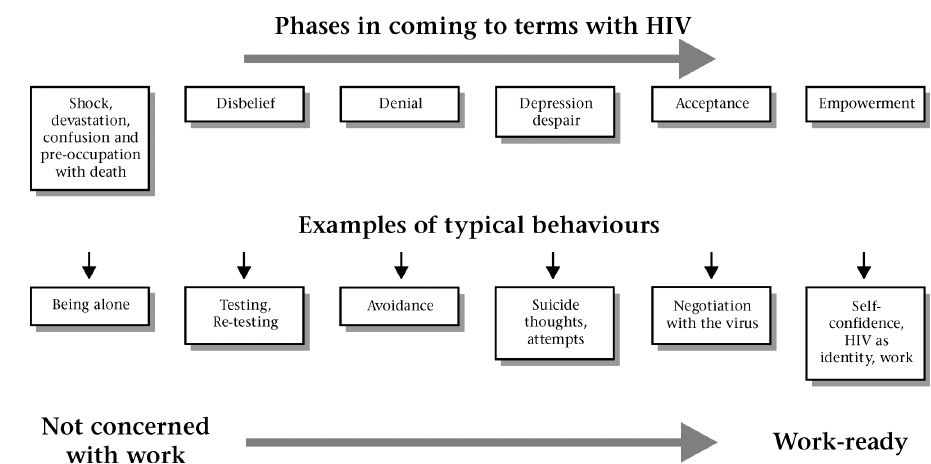
Figure 1: Relationship between phases of response to HIV and work